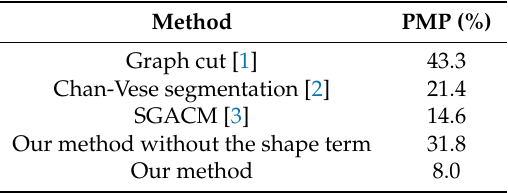
Table 3. Performance of different methods. PMP: percentage of misclassified pixels. SGACM: shape-based global minimization active contour